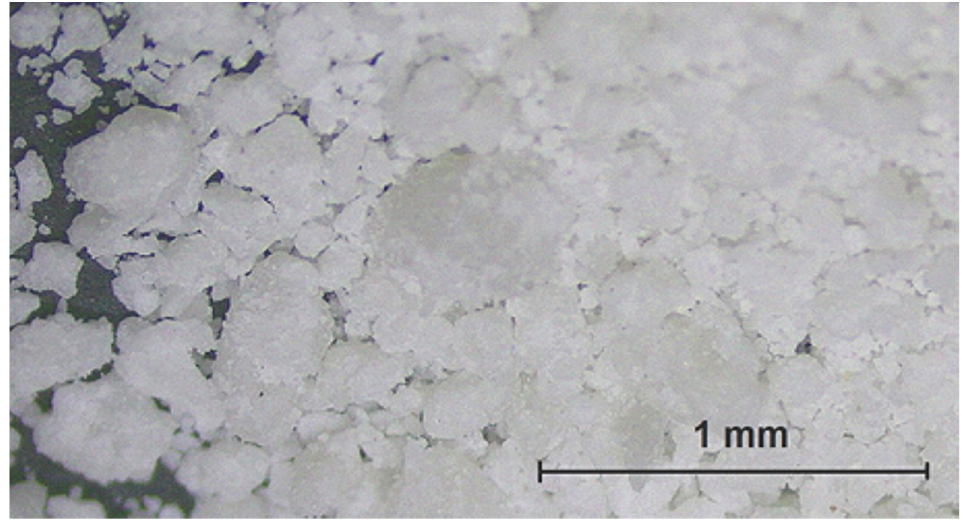
Figure 2. Granules of the polymer soap A.